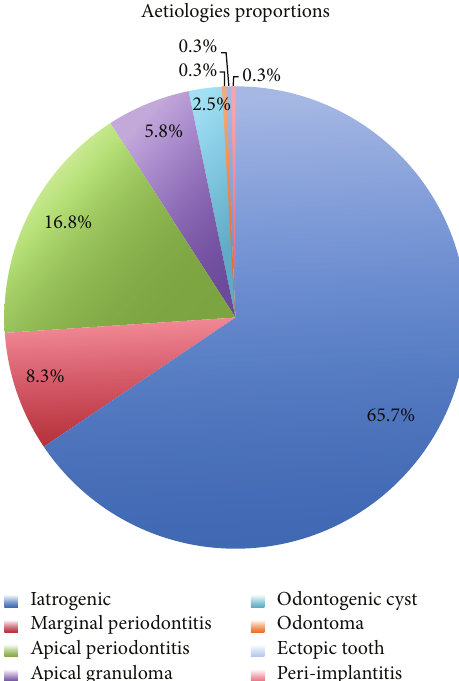
Figure 2: Aetiology of odontogenic CMRS. The main cause of odontogenic CMRS is iatrogenic and accounts for 65.7% of cases. Apical periodontal pathologies (including apical periodontitis, api- cal granulomas, and odontogenic cysts) and marginal periodontitis follow them and account for 25.1% and 8.3%, respectively. Peri- implantitis, ectopic tooth, and odontoma remain rare causes of odontogenic